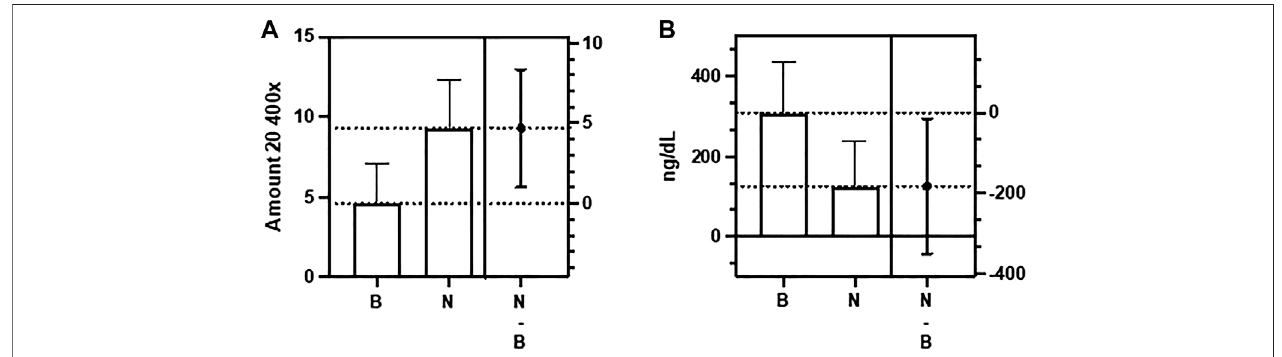
FIGURE 2 | Difference between the Control group (B) and the Nucleocapsid group (N) in relation to number of spermatozoa in testis (A) and total testosterona (B) ( p < 0,05).